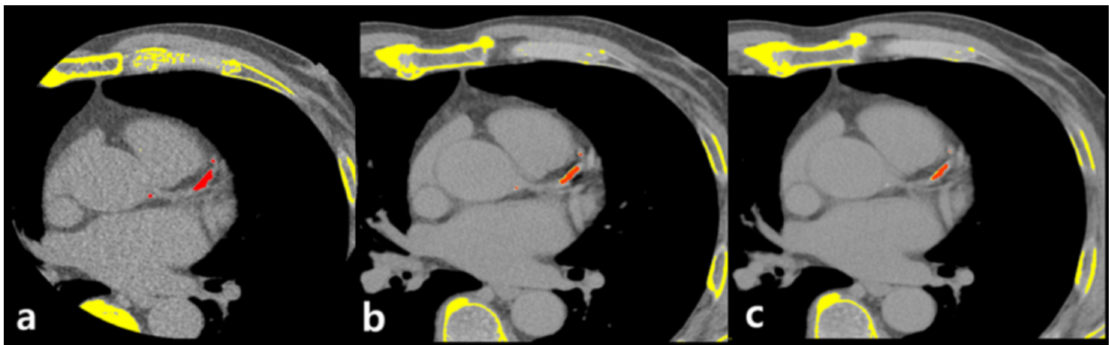
Figure 3. Representative case of coronary calcium scoring on calcium-scoring CT and chest dual energy CT. Pixels with HU > 130 are displayed in yellow and red if selected as calcium by operator. Calcium is well visualized on calcium-scoring CT ( a ), 1.25 mm slice thickness VUE image of chest DECT ( b ), and 2.5 mm slice thickness VUE image of chest DECT ( c